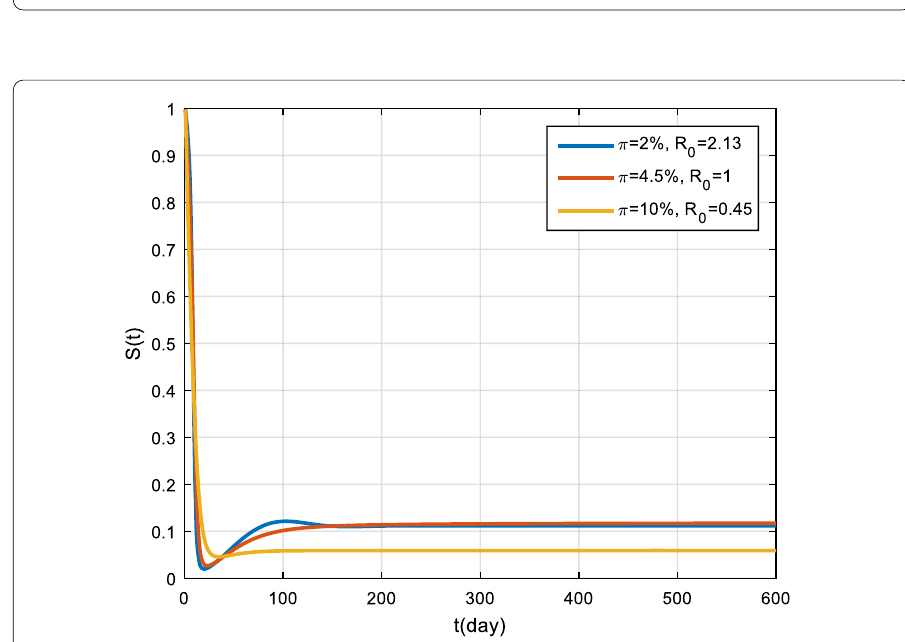
Figure 11 Variation in the number of suspected population for different values of